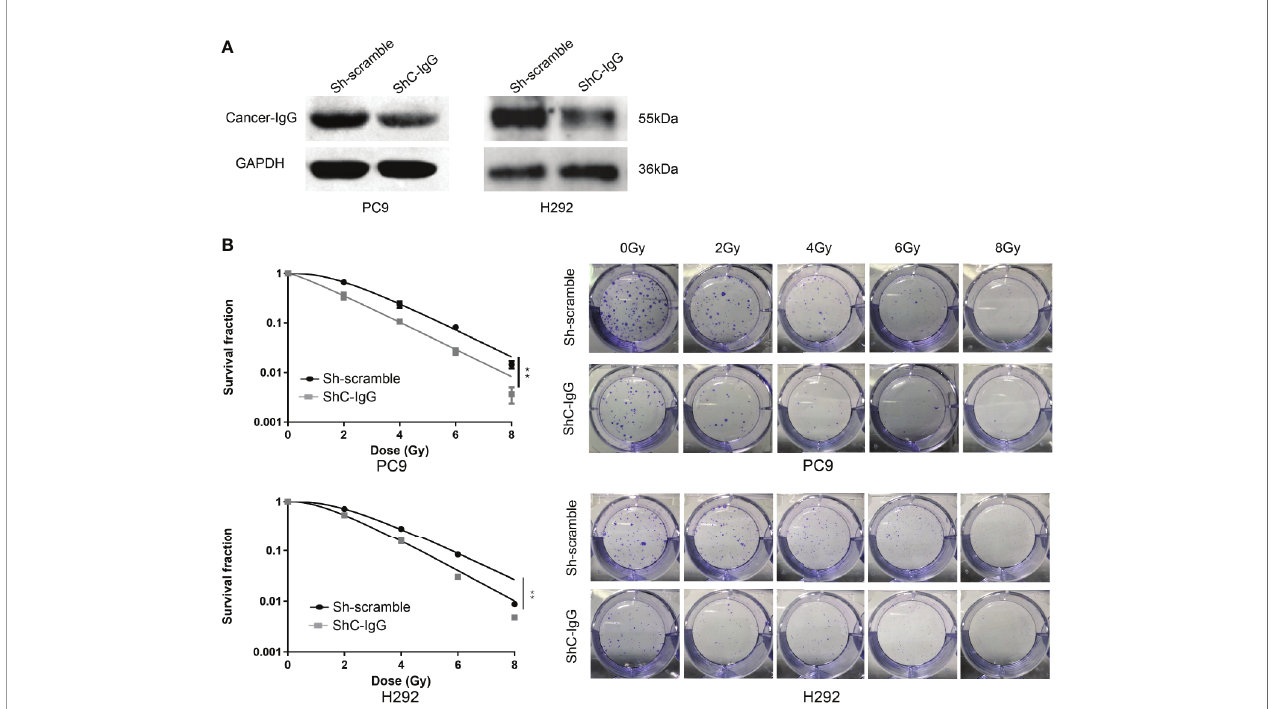
FIGURE 3 | Cancer-IgG silencing attenuates lung adenocarcinoma resistance to radiation therapy. (A) Western blotting was used to test the ef fi ciency of lentiviral interfering RNA in silencing cancer-IgG in PC9 and H292. (B) Colony-forming assay showed that the proliferation ability of PC9 and H292 cells at silencing cancer-IgG decreased after 0, 2, 4, 6, and 8 Gy of irradiation, and the single-hit multi-target model was fi tted to the survival curve. ** P < 0.01 (n=3). ShC-IgG: sh-cancer-IgG.